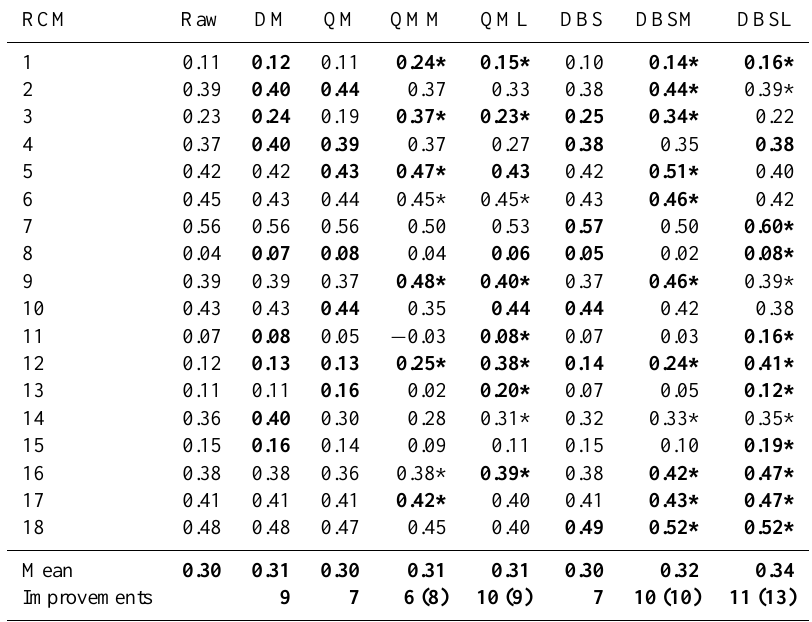
Table 3. Correlation coefficients for the annual maximum 5-day precipitation for the individual RCMs. Bold marks that the method improved the correlation compared with the raw output. Asterisks (*) denote that the conditioning on month or weather pattern improved results compared with the unconditional